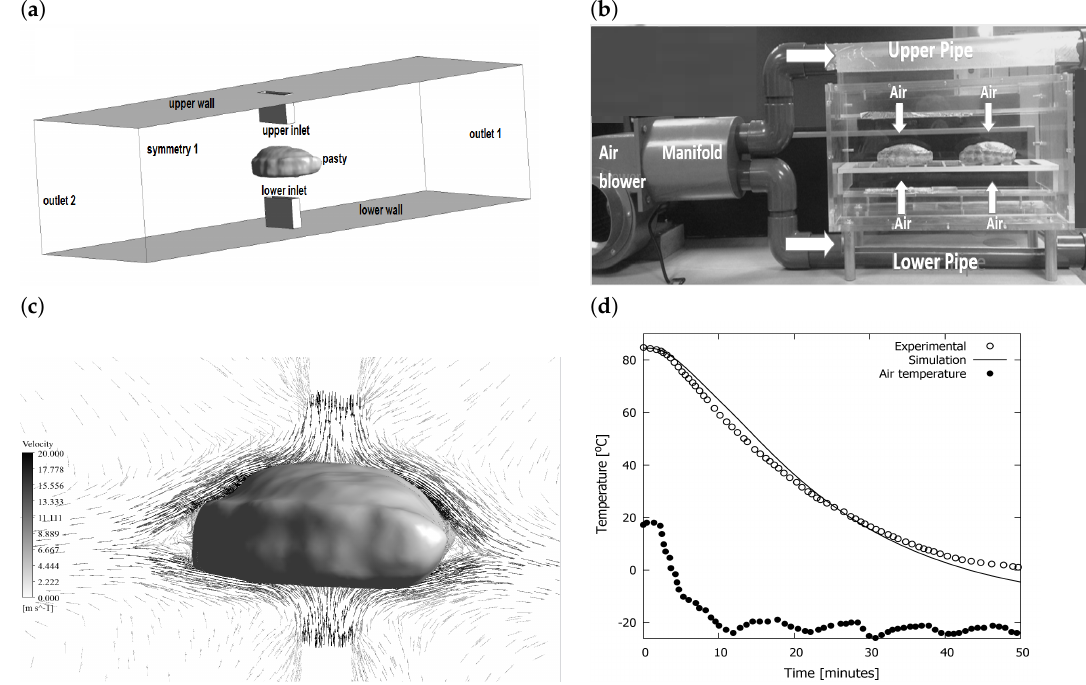
Figure 7. Computational simulation of the cooling of a single Cornish pasty. ( a ) demonstrates the overall computational domain which closely matches the experiment. ( b ) shows the equivalent experiment whilst ( c , d ) show results from the simulation for air flow and core temperature; the latter being compared with the actual measured